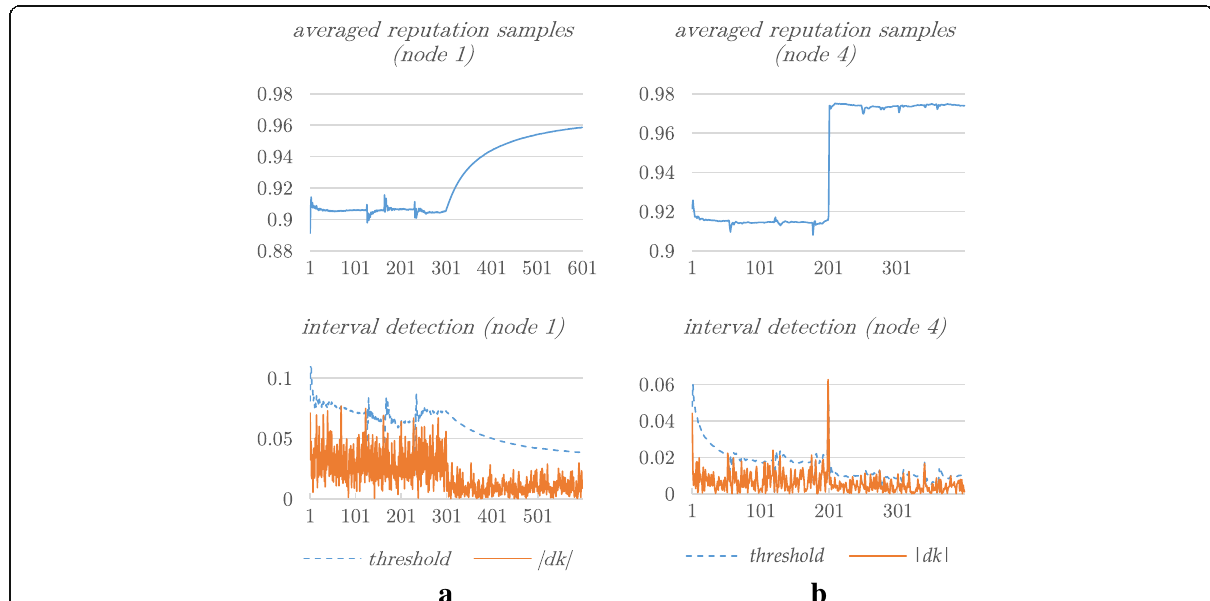
Fig. 8 Average value of the samples (figures at the top) and interval detection (figures below) when β =0.9 and F =2: a for node 1 and b for node 4